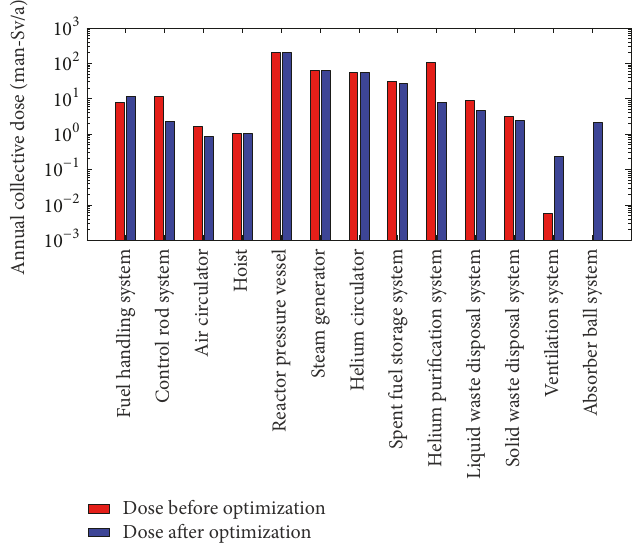
Figure 13: Collective dose of HTR-PM before and after